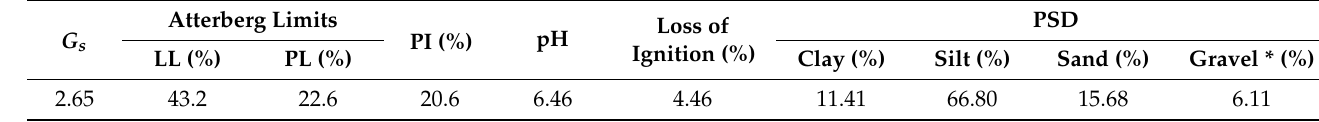
Figure 3. Sedimentation column for calibration tests. Table 3. Basic properties of HKMD.